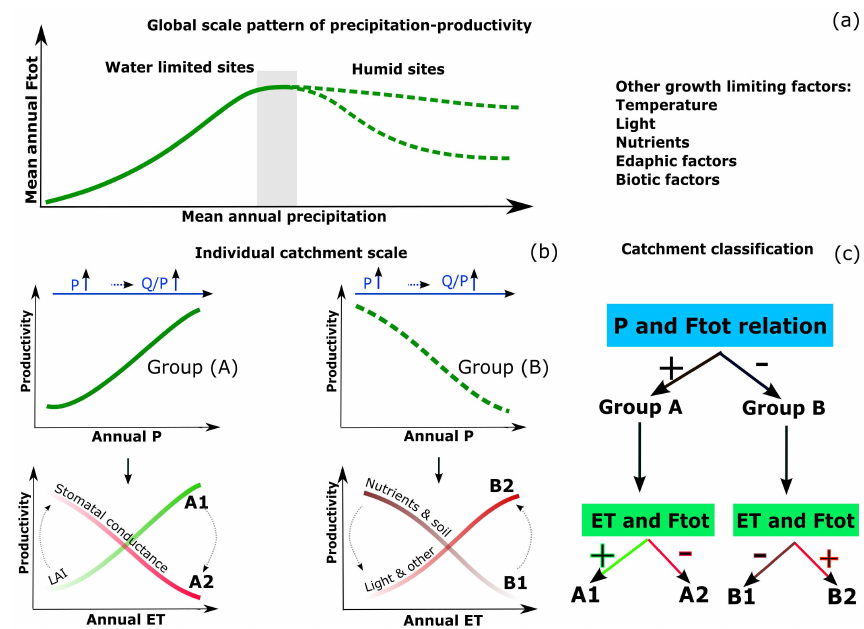
Figure 6. (a) Global pattern of annual productivity ( F tot ) and mean annual precipitation relationship. While precipitation is the primary factor for vegetation growth in water-limited sites, productivity reaches an asymptote in humid areas or decreases (e.g., tropical forests) with increases in precipitation due to biogeochemical or edaphic constraints. The grey region corresponds to catchments in which productivity is insensitive to inter-annual precipitation variability. (b) A conceptual framework for characterizing changes in runoff ratio to changes in annual precipitation and vegetation productivity ( F tot ) in relation to the catchment’s hydroclimatic condition. In group (A) catchments, a positive relationship between annual precipitation and productivity exists and annual ET changes in relation to productivity depend on the dominance of structural control (increases in LAI, class A1) versus physiological control (decreases in stomatal conductance, class A2) in controlling productivity. In group (B) catchments, an inverse relationship between precipitation and productivity exists and productivity is likely constrained by biogeochemical factors. In B1 catchments, negative ET and productivity relation indicate productivity is likely con- trolled by nutrient availability as drier conditions induce nutrient mineralization. In B2 catchments, light availability and lower temperature reduce ET. In group (A) catchments, runoff ratio would increase as productivity increases, while in group (B), runoff ratio will likely decrease with increasing productivity (decreases in precipitation). Depending on the dominance of limiting resources, precipitation–productivity may shift between the two regimes. (c) The flowchart illustrates the classification procedure. The classification starts by assessing the correlations between annual precipitation and F tot and then annual ET and F tot in a